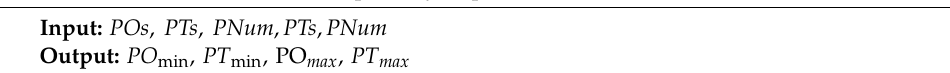
Algorithm 1. Algorithm for s electing critical collision points by slope (where, Input